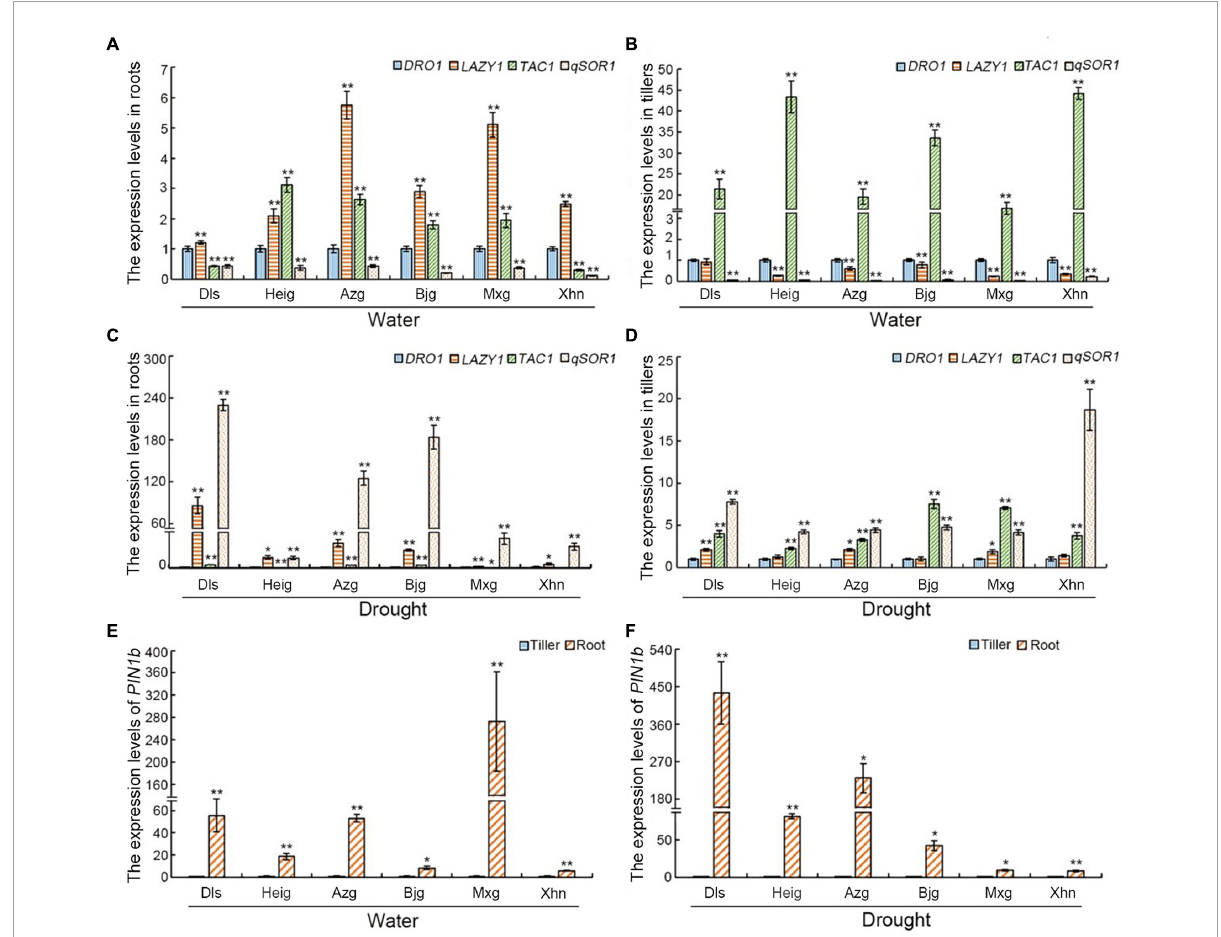
FIGURE4 Expression levels of the IGT family genes and PIN1b in rice roots and tillers. Five-month-old rice plants grown in the field with irrigation (A,B,E) or drought conditions (C,D,F) , the expression levels of the IGT family genes DRO1 , LAZY1 , TAC1 , and qSOR1 in rice roots (A,C) and tillers (B,D) , and the levels of PIN1b gene in rice roots and tillers (E,F) were determined by using real-time PCR. The Actin gene was used as an internal control. Data are means ± SD. * P < 0.05, ** P < 0.01 (SPSS analysis). Dls, Da Leng Shui; Heig, Hei Gu; Azg, Ai Zhe Gu; Bjg, Ban Jiu Gu; Mxg, Ma Xian Gu; Xhn, Xiao Hua